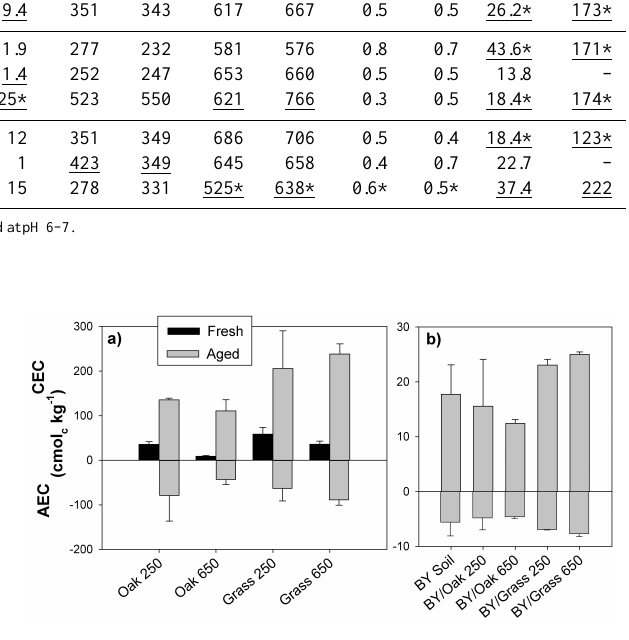
Figure 2. Cation and anion exchange capacities (CEC and AEC, respectively) measured at pH 6–7 on (a) fresh and “aged” oak and grass biochars produced at 250 and 650 ◦ C, and (b) aged BY soil and BY soil–biochar